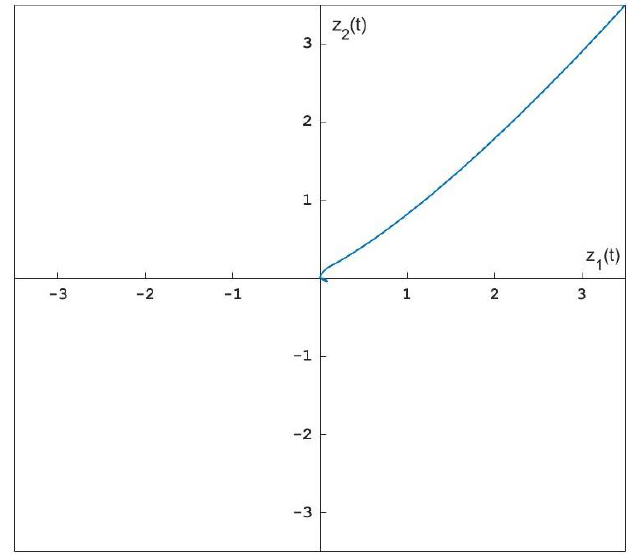
Figure 2. The solution trajectory of the system